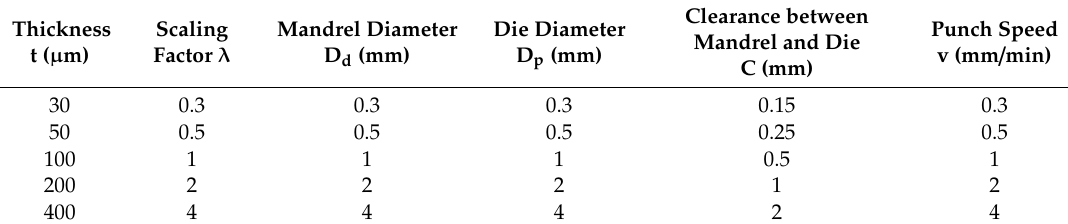
Table 3. Parameters in similarity bending experiments.